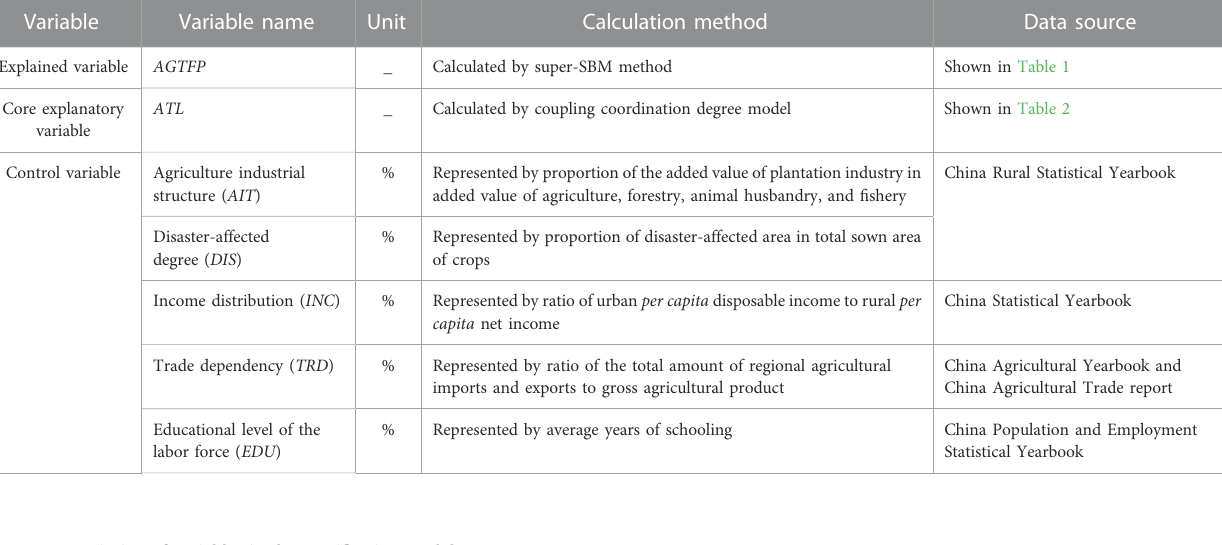
TABLE 4 Description of variables in the speci fi cation